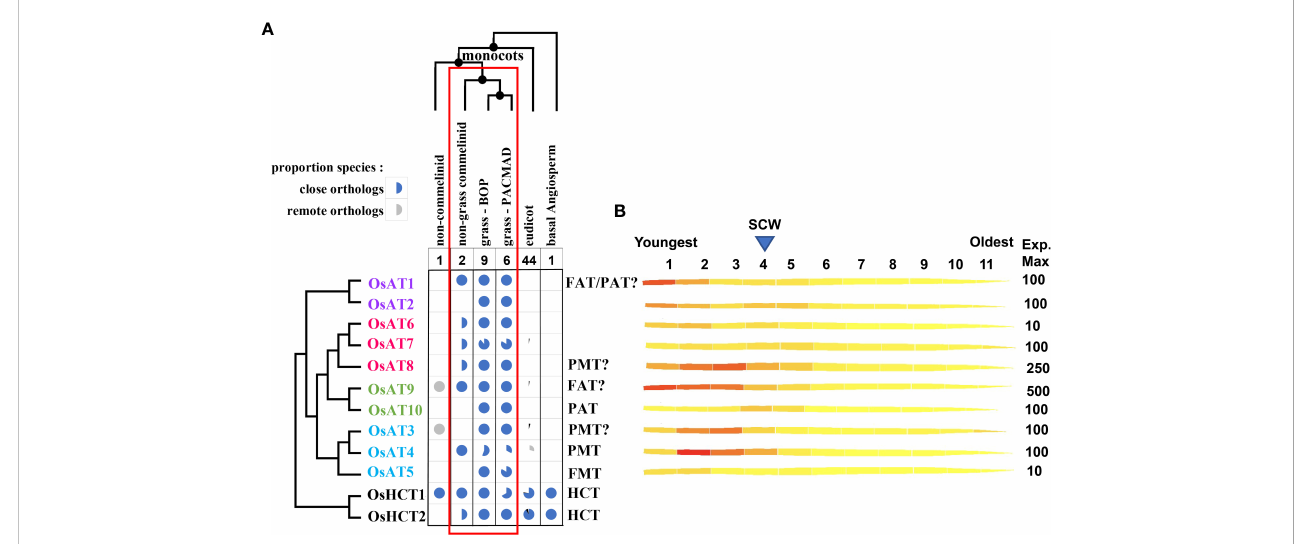
FIGURE 5 Taxonomy and expression pro fi les of Mitchell subclade acyltransferases. (A) Taxonomic distribution of ATs and their known and putative activities. Pie charts indicate the proportion of species with orthologs to the Mitchell subclade OsAT genes and to two BAHD Clade V HCT genes encoding shikimate O-hydroxycinnamoyl transferases, a key enzyme in the phenylpropanoid pathway expected to be present in all plants. All species have close orthologs to HCT1 and/or HCT2 whereas only commelinid monocots have close orthologs to AT genes, which matches the taxonomic distribution of FA-GAX indicated by the red rectangle. The species are all angiosperms with fully sequenced genomes present in Ensembl Plants release 54; close and remote orthologs de fi ned as reciprocal blastp top hits with bitscore > 400 and 300 respectively. Text colors indicated the subgroups in Figure 4. FAT indicates likely feruloyl arabinose transferase; PAT indicates likely p -coumaryl arabinose acyltransferase; FMT indicates ferulate monolignol transferase; PMT indicates p -coumarate monolignol transferase. Question marks indicate that existing evidence is contradictory or relatively weak. (B) AT expression across the rice leaf gradient generated from the eFP (electronic fl uorescent pictograph) browser of the Bio-Analytic Resource for Plant Biology (BAR), the University of Toronto (Sullivan et al., 2019) using Wang et al. (2014a) leaf expression data. The rice leaf gradient includes the youngest tissue in the 1 st segment and the oldest in the 11 th segment with secondary cell wall (SCW) related expression peaking at segment